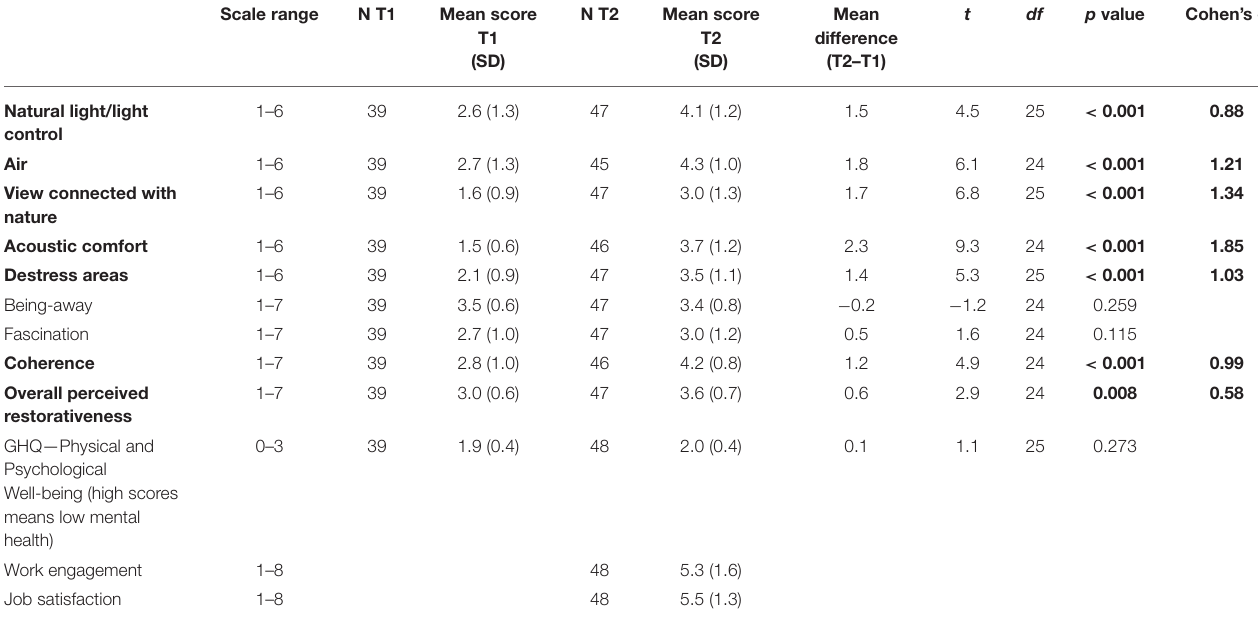
TABLE 1 | Descriptive statistics for the considered variables in the two surveys, and results of the paired sample t -test comparing first and second assessment on the same